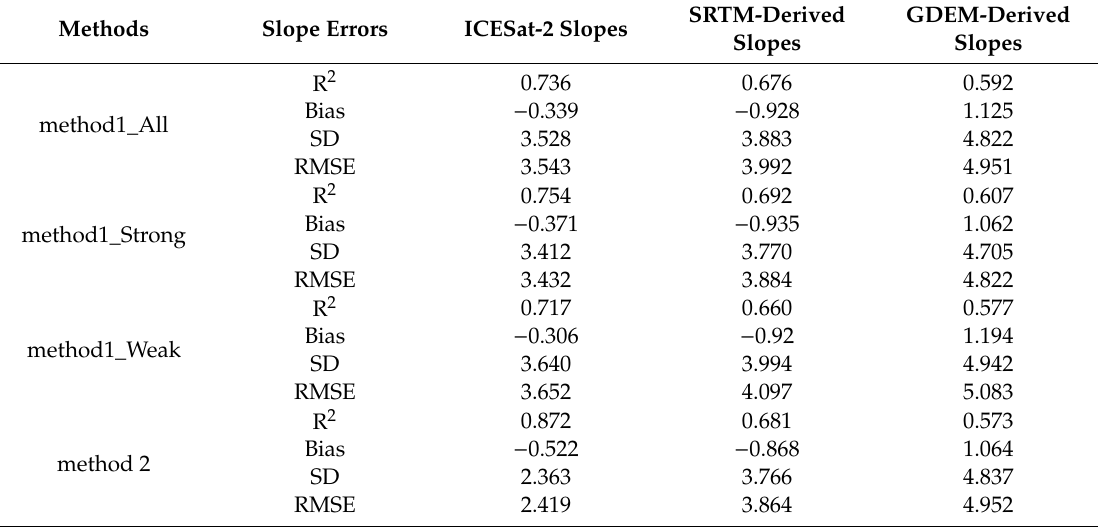
Table 4. The comparison results among ICESat-2 estimated slopes, SRTM-derived slopes, and GDEM-derived slopes.